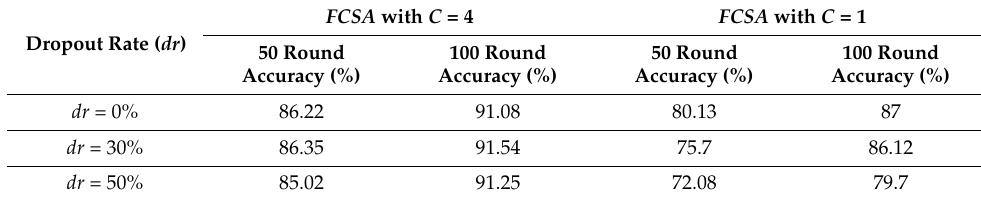
Table 4. Accuracy according to different dropout rates.